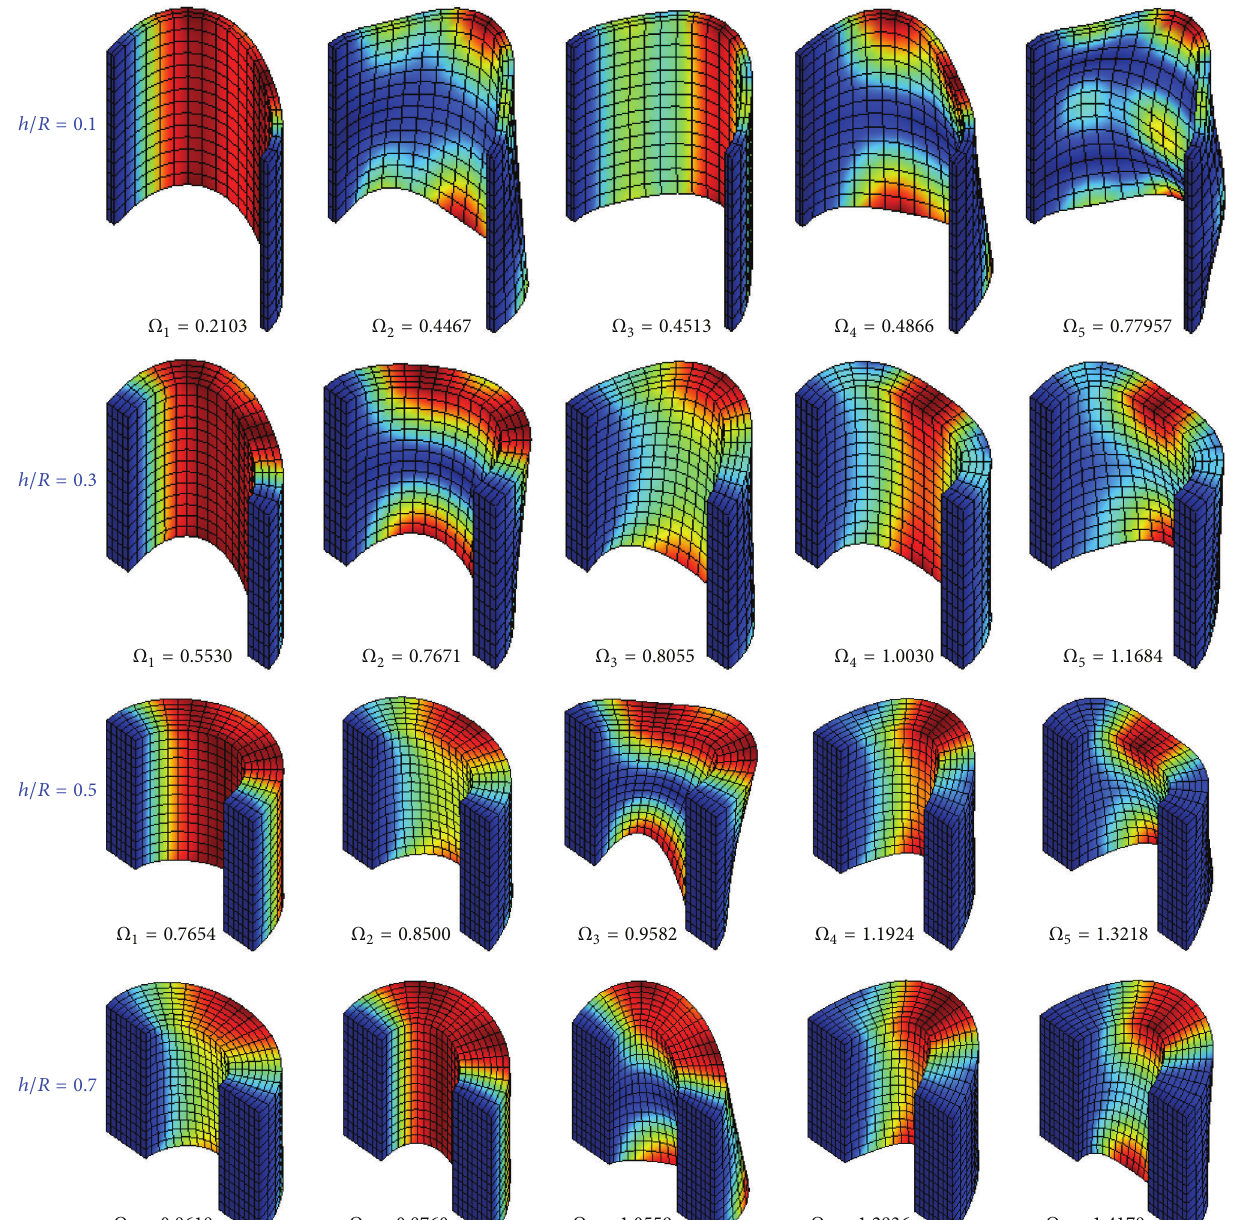
Figure 3: Mode shapes of an isotropic cylindrical shell with FCFC boundary conditions and various thickness-radius